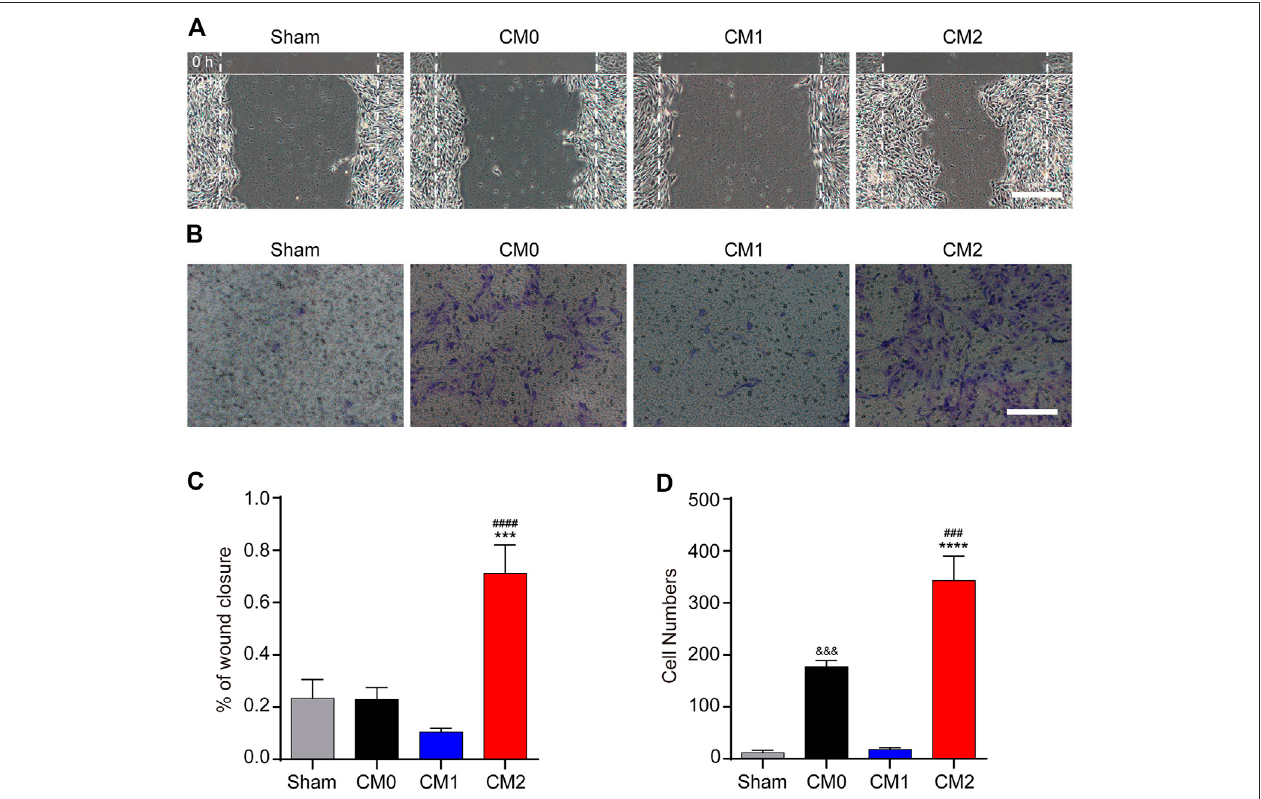
FIGURE 4 | M2 macrophages promote the migration of PDGFR β + pericytes in vitro . (A) Scratch test was used to detect the migration of PDGFR β + pericytes after being treated with DMEM (Sham), conditioned medium of M0 macrophages (CM0), conditioned medium of M1 macrophages (CM1), or conditioned medium of M2 macrophages(CM2)for72 h( n (cid:2) 3pergroup). (B) TranswelltestwasusedtofurtherdetectthemigrationofPDGFR β + pericytesafterbeingtreatedinSham,CM0,CM1, orCM2groupsfor20 h( n (cid:2) 3pergroup) (C) Quantitativeanalysisofthewoundclosureratein (A) .Theresultswereexpressedasmean ± SD.*** p < 0.001(CM2vs. Sham and CM0); #### p < 0.0001 (CM2 vs. CM1) (D) Quantitative analysis of the number of transmembrane cells in (B) . The results were expressed as mean ± SD. **** p < 0.0001 (CM2 vs. Sham and CM1); ### p < 0.001 (CM2 vs. CM0). &&& p < 0.001 (CM0 vs. Sham and CM1). Scale bars, 100 μ